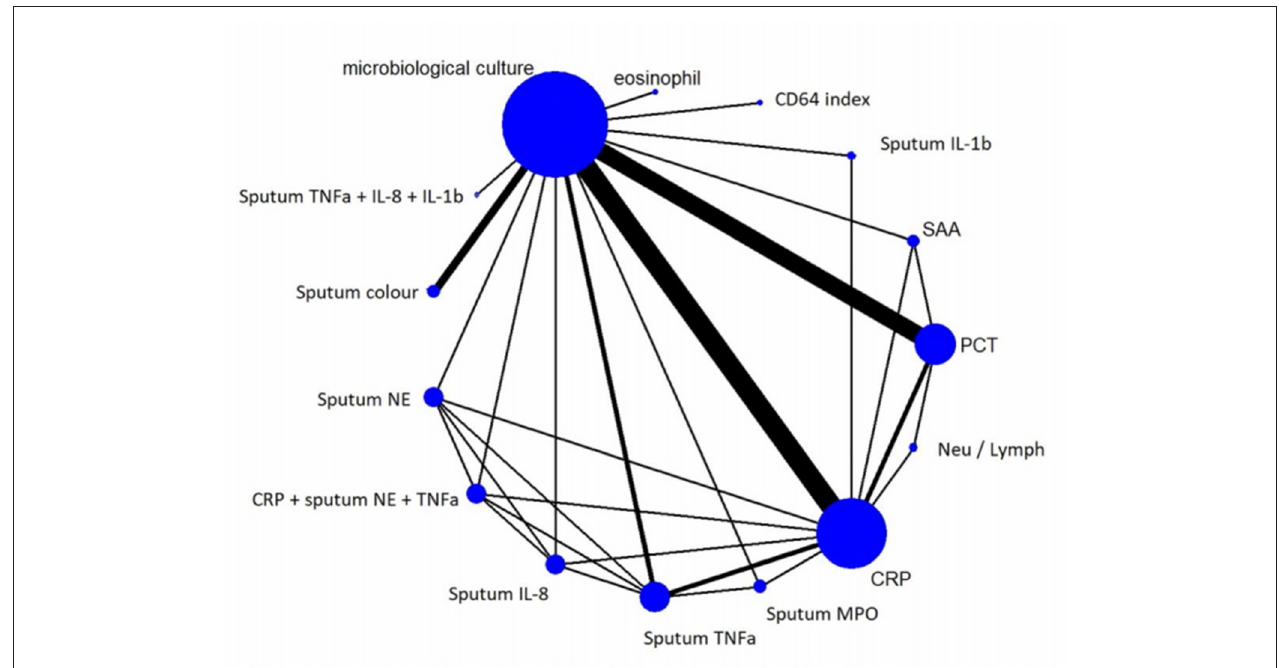
FIGURE 4 | Network Graph. The network graph enables visualization of the relations between examined index tests and the reference standard. The nodes represent the tests and the edges show the direct head-to head trials. The thickness of the edges is proportional to the number of direct head-to-head trials, and the size of the nodes is proportional to the sample sizes. CRP and PCT were the most commonly investigated biomarkers for predicting bacterial infection compared to microbiological culture in AECOPD. CRP, C-reactive protein; IL-1b, interleukin one beta; IL-8, interleukin eight; MPO, myeloperoxidase; NE, neutrophil elastase; N/L, neutrophil-lymphocyte ratio; PCT, procalcitonin; SAA, serum amyloid A; TNFa, tumor necrosis factor